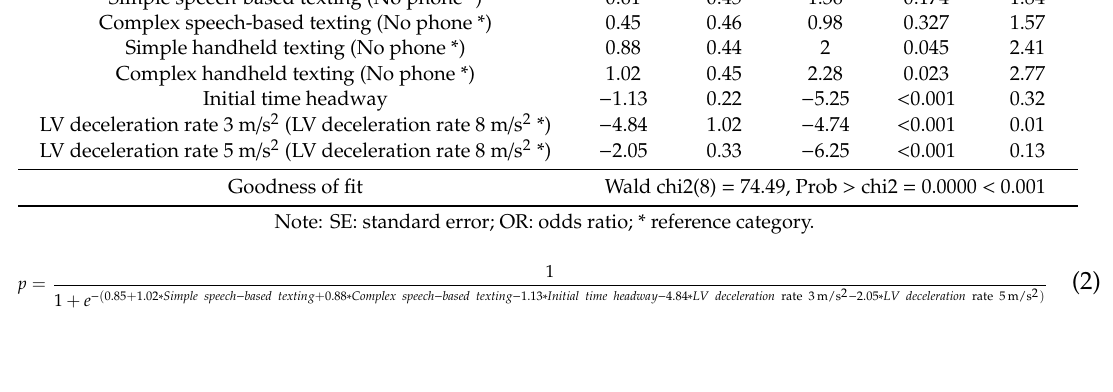
Table 3. Model results for rear-end accident probability during a sudden braking event. Parameter